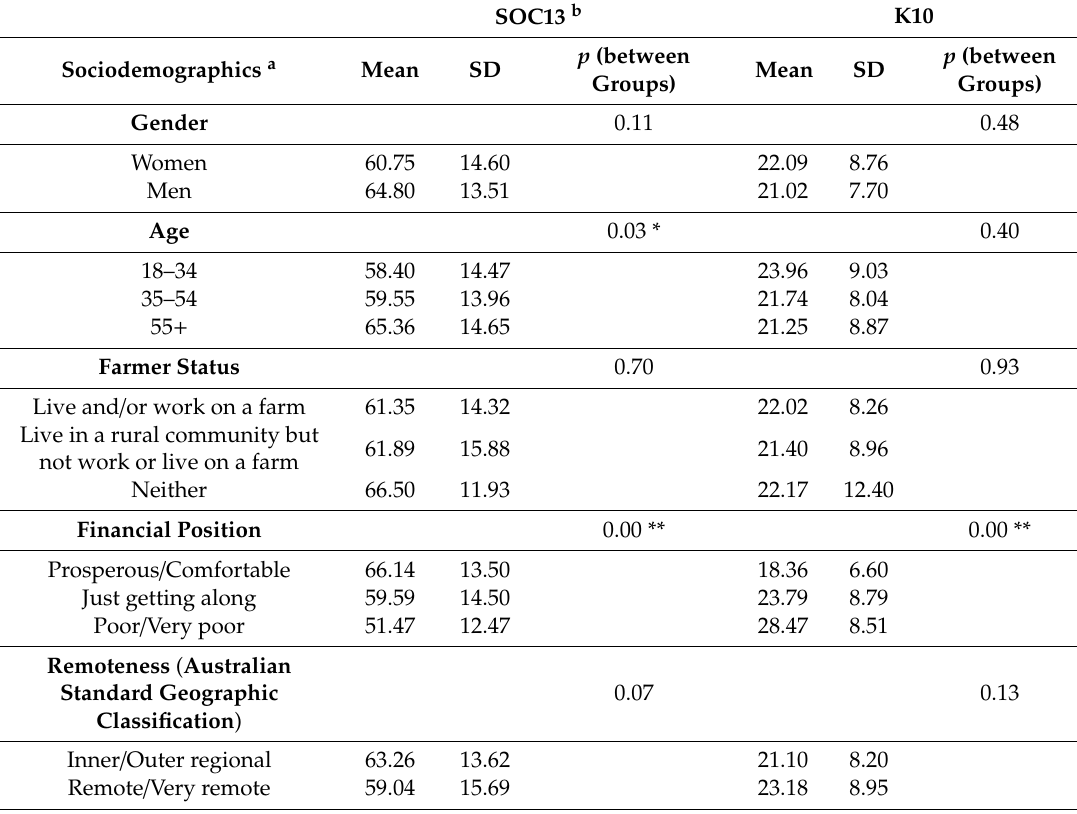
Table 6. Univariate analysis of sociodemographics with SOC13 and K10.